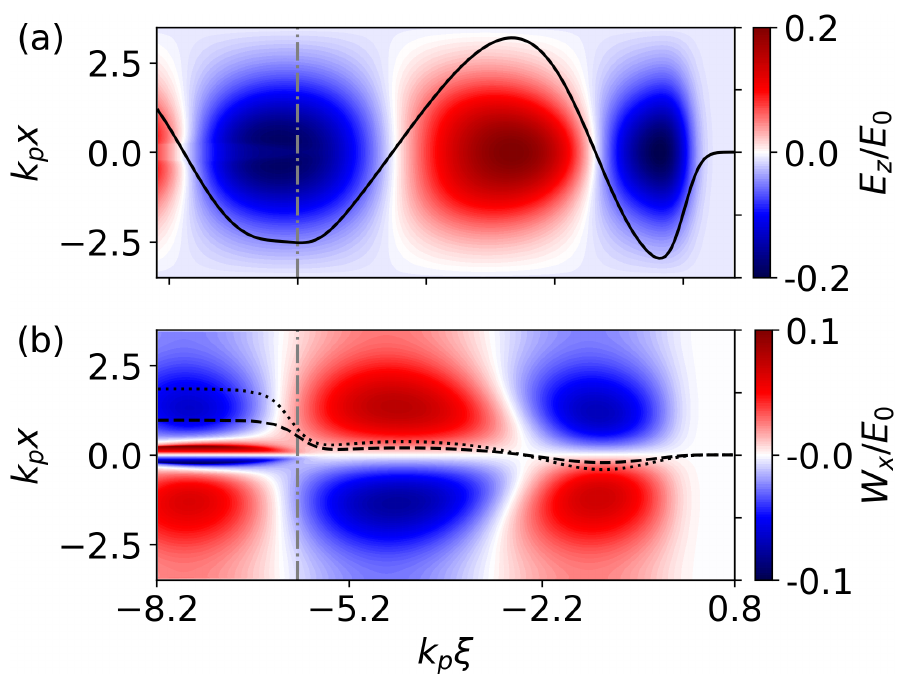
Figure 2. Plasma wakefields for the low-charge (120 pC) case in colourmaps. ( a ) The longitudinal wakefield E z . The 1D lineout shows the on-axis value of E z , whose value range is the same as the right colorbar. ( b ) The transverse wakefield W x = E x − cB y . The dashed line and the dotted line show the value at r = σ re and r = 2 σ re , respectively. The initial loading position ξ 0 e (or the longitudinal centroid) of the witness electron bunch, shown by vertical grey dash-dotted lines in both plots.